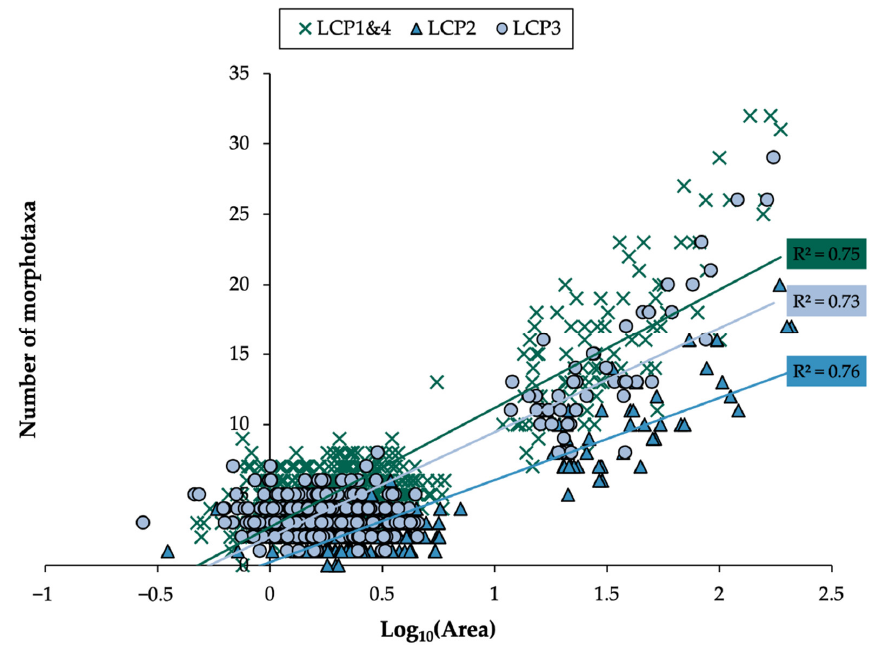
Figure 2. Ice-shelf-adjacent sites accumulate faunal richness differently. Morphotaxa richness with area surveyed for sites LCP1-4 (note, slopes for LCP1 and LCP4 were not significantly different from each other, p > 0.2, therefore, datasets pooled). Significantly different slopes are shown ( p -values for differences between slopes all <0.01). For regression lines, F-values = 1546.39, 767.44, and 930.35, for LCP1 and LCP4 combined, LCP2, and LCP3, respectively, with p -values all <0.001. When comparing standardized 100 m 2 samples (three per site), the lowest richness was observed in an LCP2 sample and the highest in an LCP4 sample, with 11 and 31 mor- photaxa recorded, respectively. An LCP1 sample exhibited the second-highest richness at 27 different morphotaxa. The richness of LCP4 samples was varied, with the value of one sample being almost double of another (16 and 31), whereas the richness of LCP3 samples was noticeably more uniform (23, 24 and 25). Marked variability in richness was found at the sites closest to the ice-shelf front, with richness more than doubling from the poorest to richest sample (11 and 27). In terms of a relationship with proximity to the ice shelf, richness did not significantly alter with increasing distance from the ice-shelf front (regression-associated ANOVA, F = 1.0, p = 0.33). However, when LCP1 samples were excluded from the exploration, as they were located within a different water mass (see [90]), the relationship became more robust although remained non-significant (R 2 value = 0.4, and regression-associated ANOVA, F = 4.6, p = 0.06). Overall, a weak (inverse) relationship was observed between richness and “hard- ness” of substratum (Figure S2, F = 6.59, p = 0.03), although richness did halve from pre- dominantly soft-sedimented (with incidences of mixed) substratum through to assorted hard sediment-boulder fields. 3.4. Megafaunal Density and Pattern with Ice-Shelf Proximity and Substratum Hardness Across samples, mean benthic megafaunal density varied by nearly an order of mag- nitude, from 2.5 to 9.7 ind. m −2 (see y-axis of Figure 3). The lowest densities were typically found at LCP2 (all three samples observed to be faunally depauperate) and the highest densities generally at LCP4; although, at LCP1, closest to the ice-shelf edge, faunal